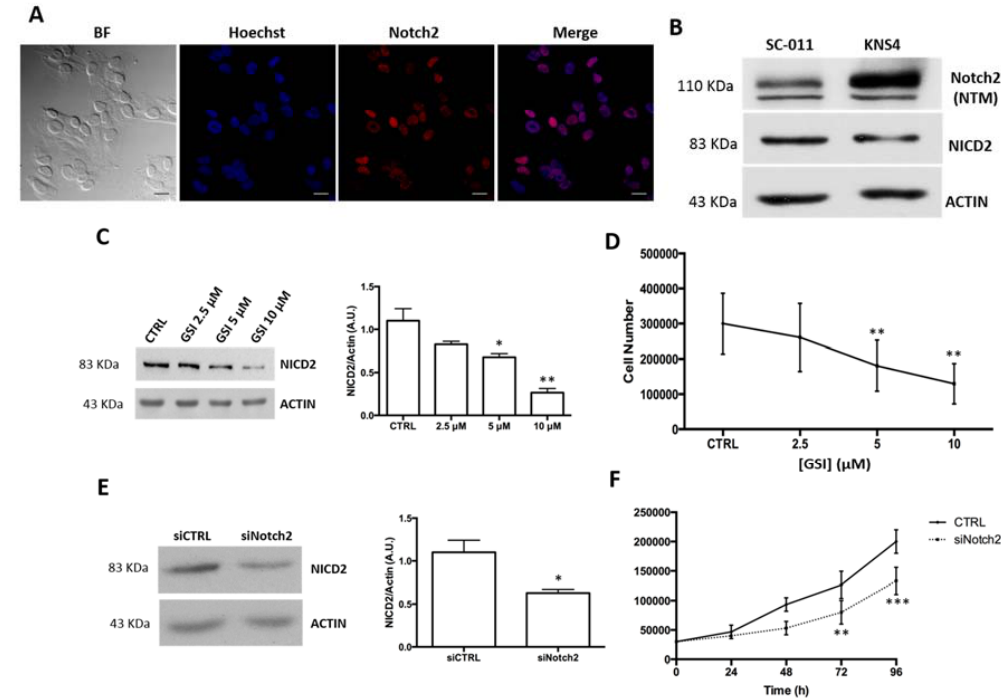
Figure 2. Notch2 expression in KNS42 cells and the impact of its inhibition on proliferation. ( A ) Immunofluorescence labeling of Notch2 expression in KNS42 cells counterstained with the nuclear marker Hoechst. (BF, bright field.) Scale bars: 20 µ m; ( B ) Western blot analysis of the trans-membrane form of Notch2 (Notch2 NTM) and NICD2 levels in KNS42 cells and SC-011 cells (used as positive controls); ( C , D ) dose-dependent effects of 96 h exposure to GSI on ( C ) NICD2 levels and ( D ) proliferation in KNS42 cells; ( E,F ) Effects of siRNA-mediated knockdown of Notch2 in KNS42 cells; ( E ) Western blot analysis of NICD2 levels 96 h after transfection. ( F ) Time-course of the effects of Notch2 silencing on KNS42 cell proliferation. * p < 0.05, ** p < 0.01, *** p < 0.001 vs. CTRL (untreated cells in panel C and D, silencing negative control-transfected cells in panel E and F). 2.3. Notch2 High Levels Are Maintained by Low Levels of miR-107, miR-181c and